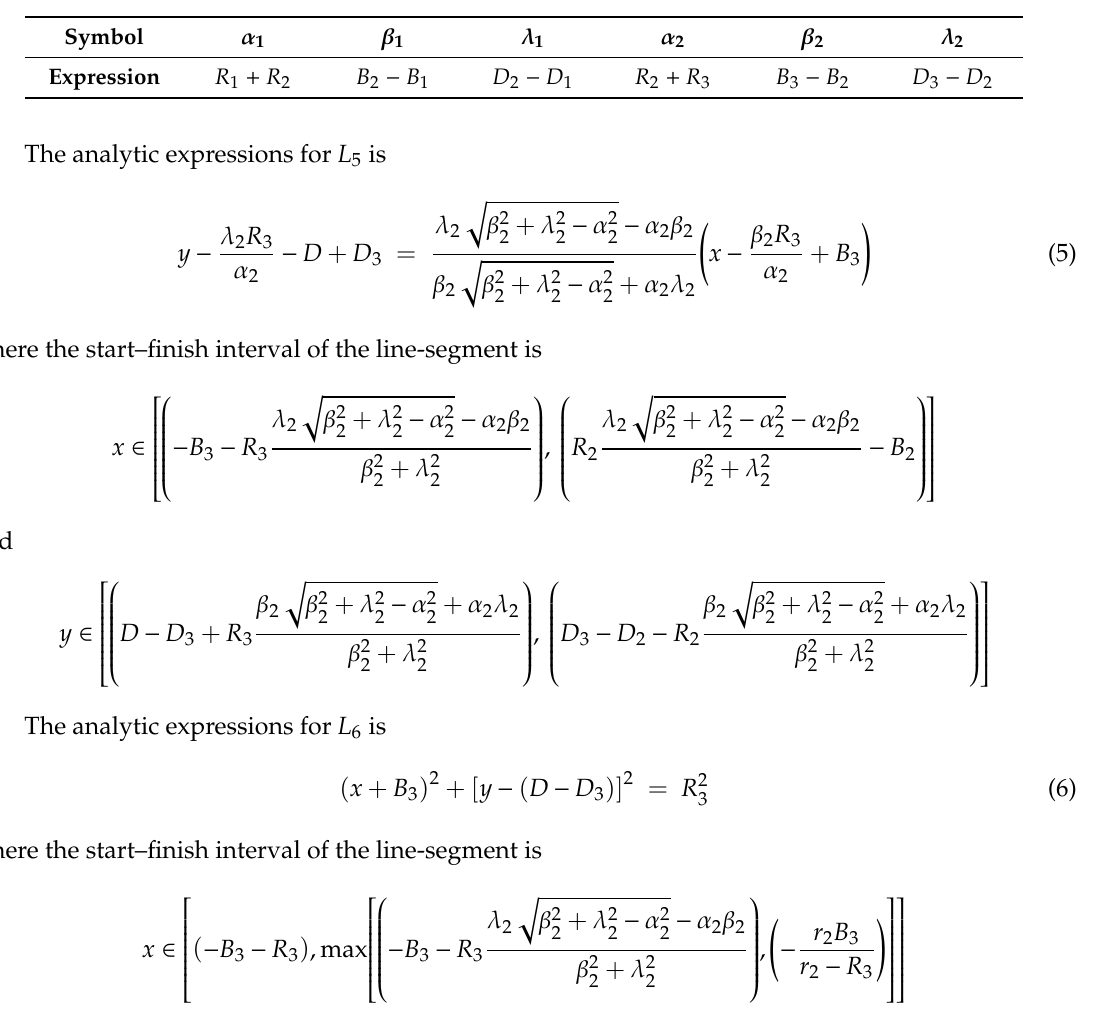
Table 1. Expression of the intermediate